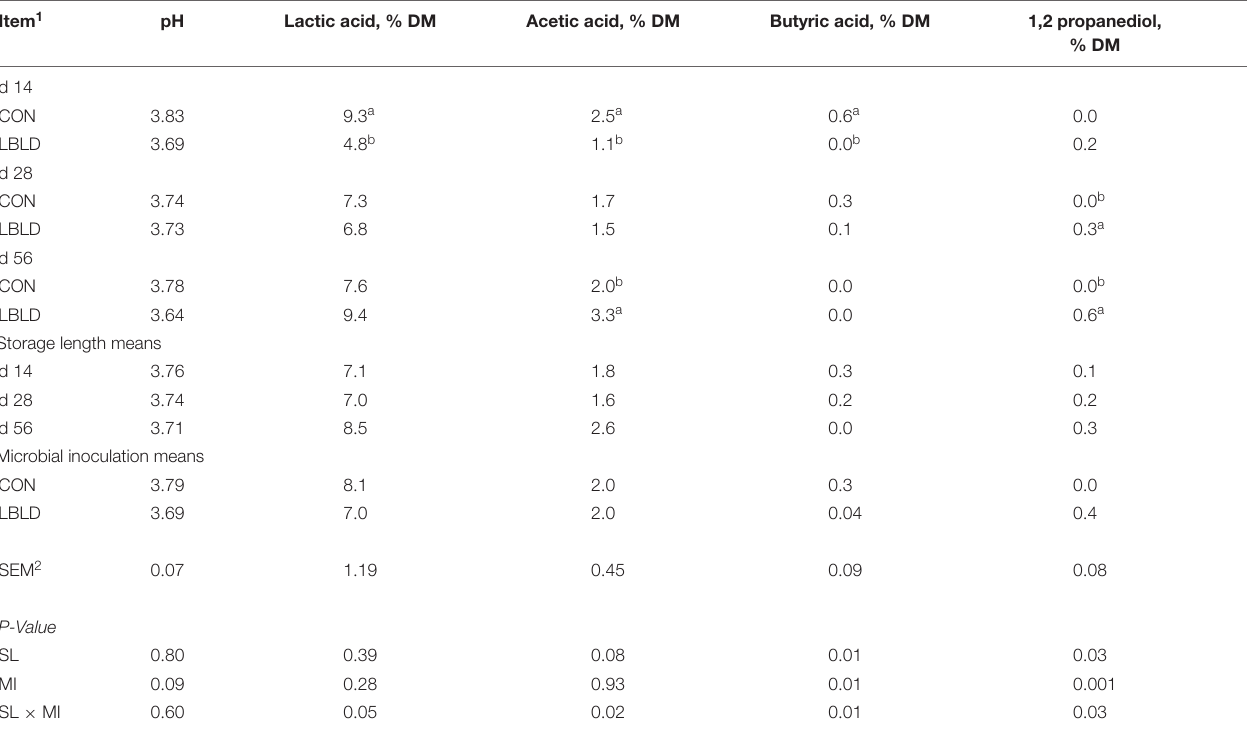
TABLE 8 | Effect of microbial inoculation and storage length on the fermentation profile of whole-plant sorghum-sudangrass silage in experiment 2. Item 1 pH Lactic acid, % DM Acetic acid, % DM Butyric acid, % DM 1,2 propanediol,